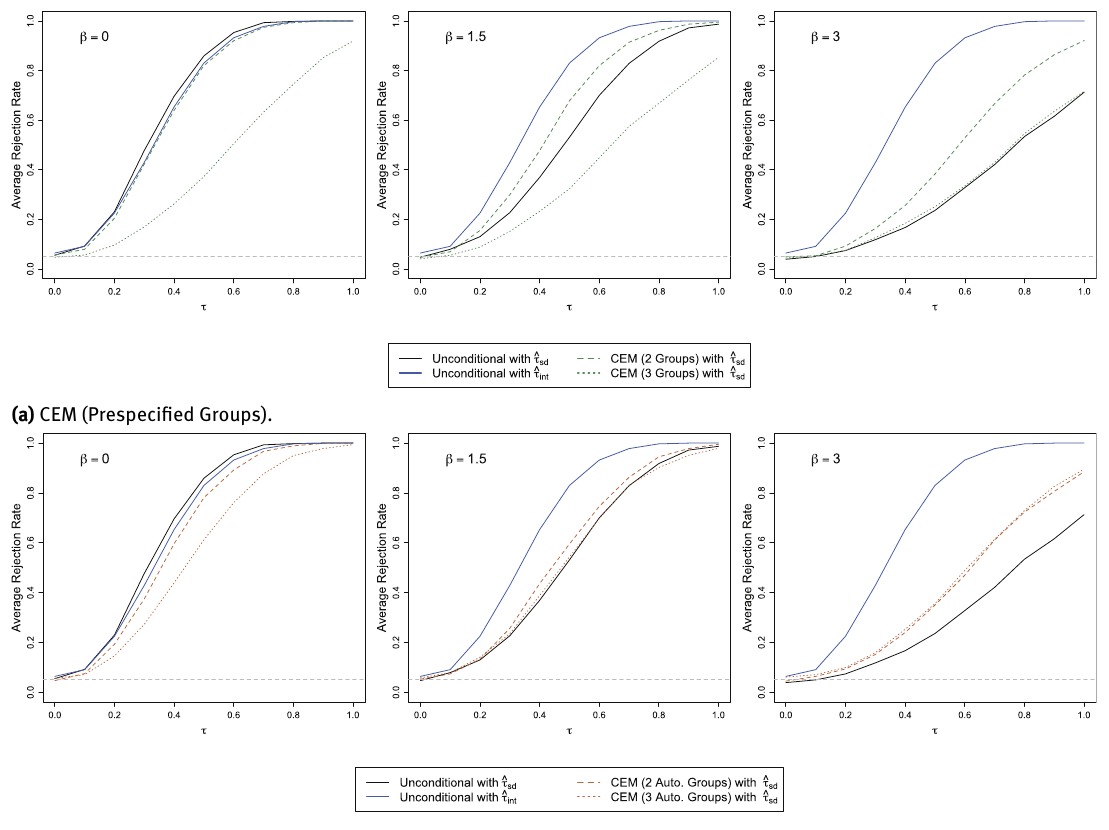
Figure 7: Power results for the CEM (Prespecified Groups) and CEM (Automatic Groups) procedures for various number of groups for each covariate under the unbalanced design scenario where N T = 25 and N C = 75. Also shown are results for the uncondi- tional tests using ̂ τ sd and ̂ τ int , which are the same results from Figure